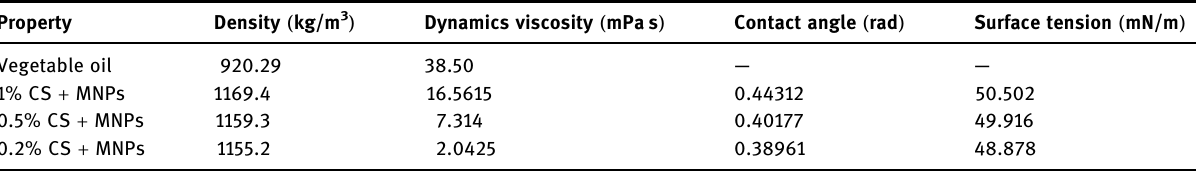
Table 2: Fluid properties used in this simulation